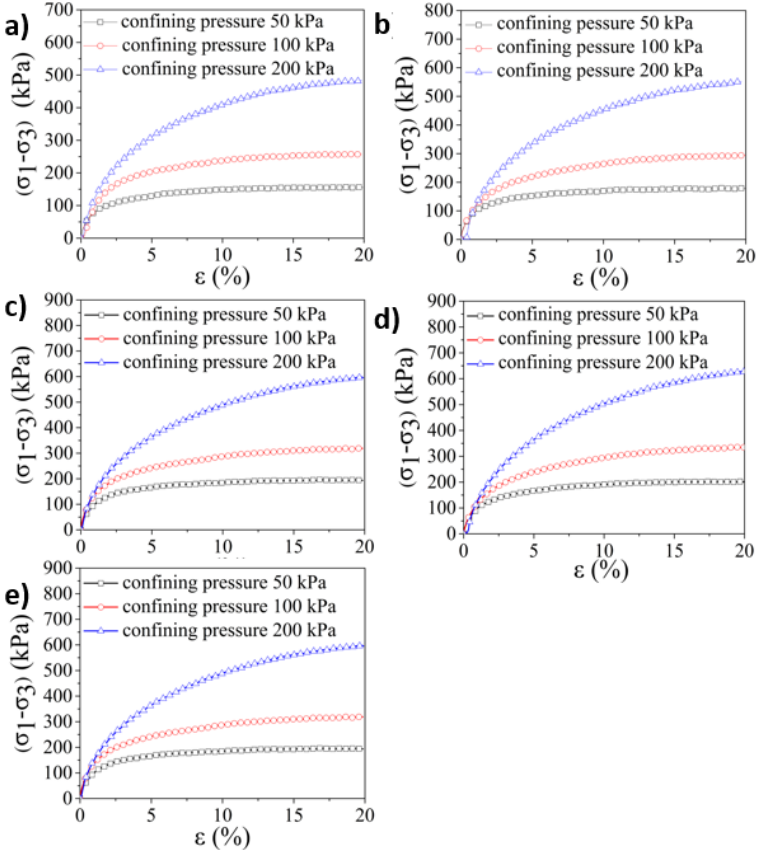
Figure 6. Deviator stress-axial strain curves of remolded Pisha sandstone during triaxle compressive